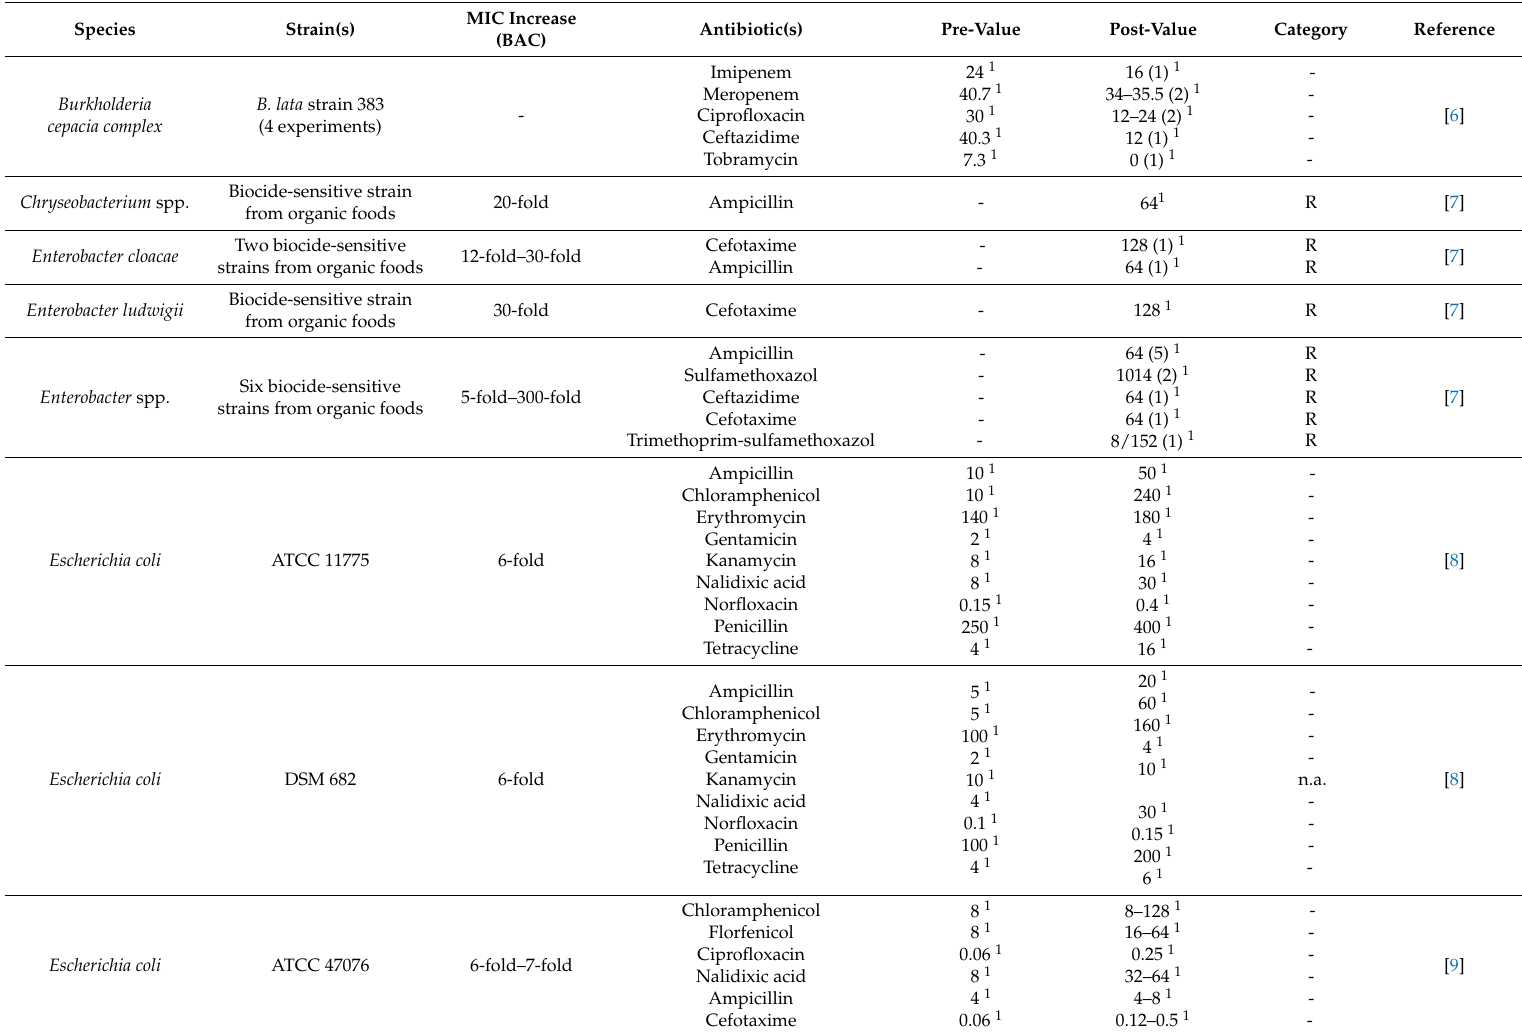
Table 2. Gram-negative species with antibiotic resistance after various types of low level exposure (<MIC value) to BAC. MIC Increase Antibiotic(s) Pre-Value Post-Value Category Species Strain(s) (BAC)